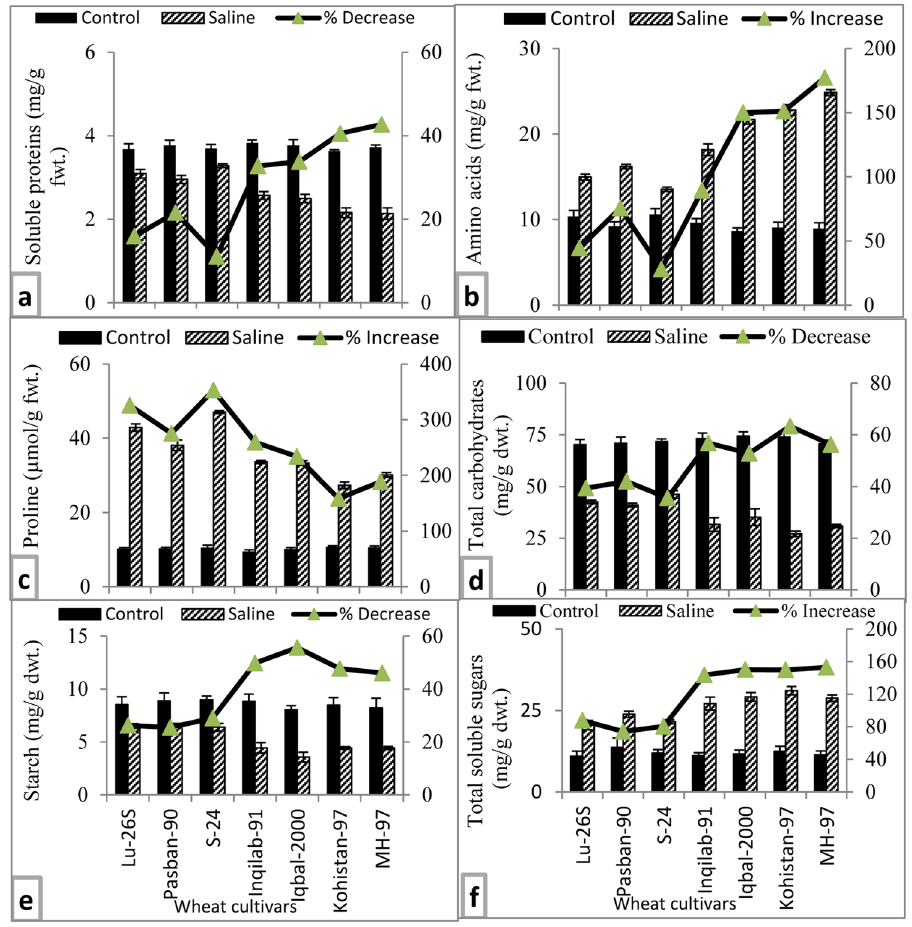
Figure 5. Soluble proteins, amino acids, proline, total carbohydrates, starch and soluble sugars of selected salt tolerant and sensitive wheat cultivars at adult stage when plants of each cultivar were subjected to 0 or 150 mM NaCl salinity stress. Means are presented on primary vertical axis, while percent increase/decrease value is presented on secondary vertical